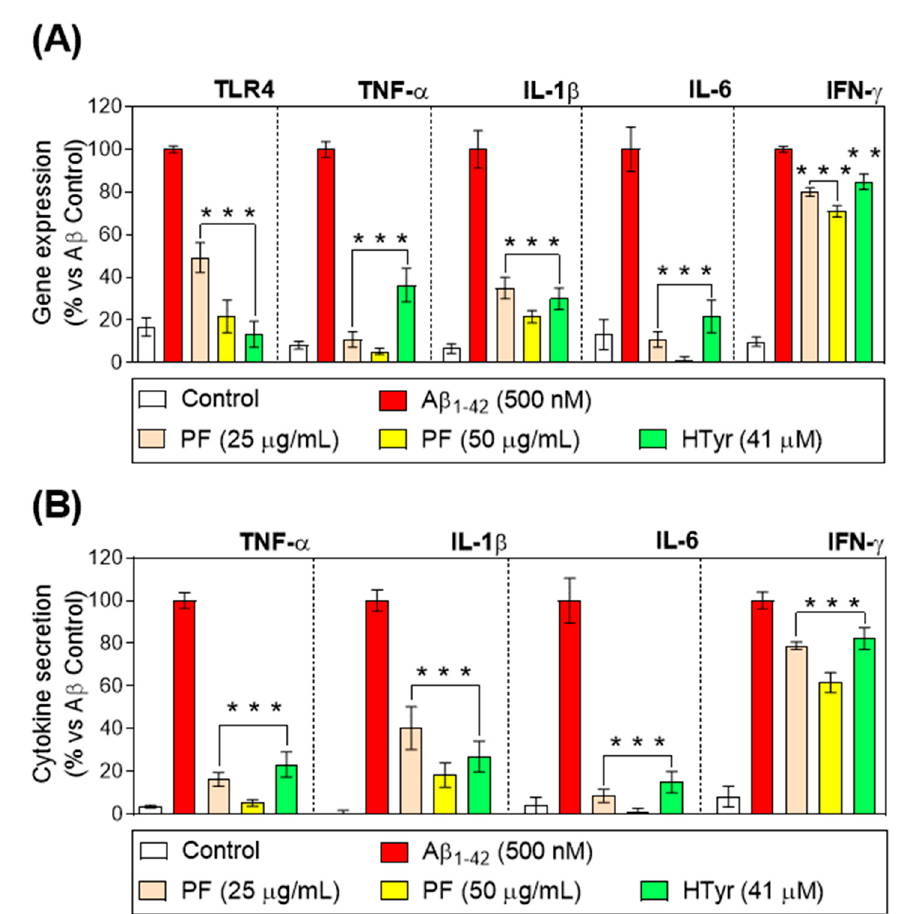
Figure 2. ( A ) Relative gene expression of TLR-4, tumor necrosis factor (TNF)- α , interleukin (IL)-1 β , IL-6, and interferon (IFN)- γ . ( B ) Cytokine expression of TNF- α , IL-1 β , IL-6, and IFN- γ after the treatment of A β 1-42 -stimulated primary human neutrophils with the PF from VOO (25 and 50 µ g/mL) or hydroxytyrosol (HTyr, 41 µM) for 6 h. Values are means of the three independent experiments in triplicate, with their standard errors represented by vertical bars (** p < 0.01; *** p < 0.001 vs. A β 1-42 -treated cells).